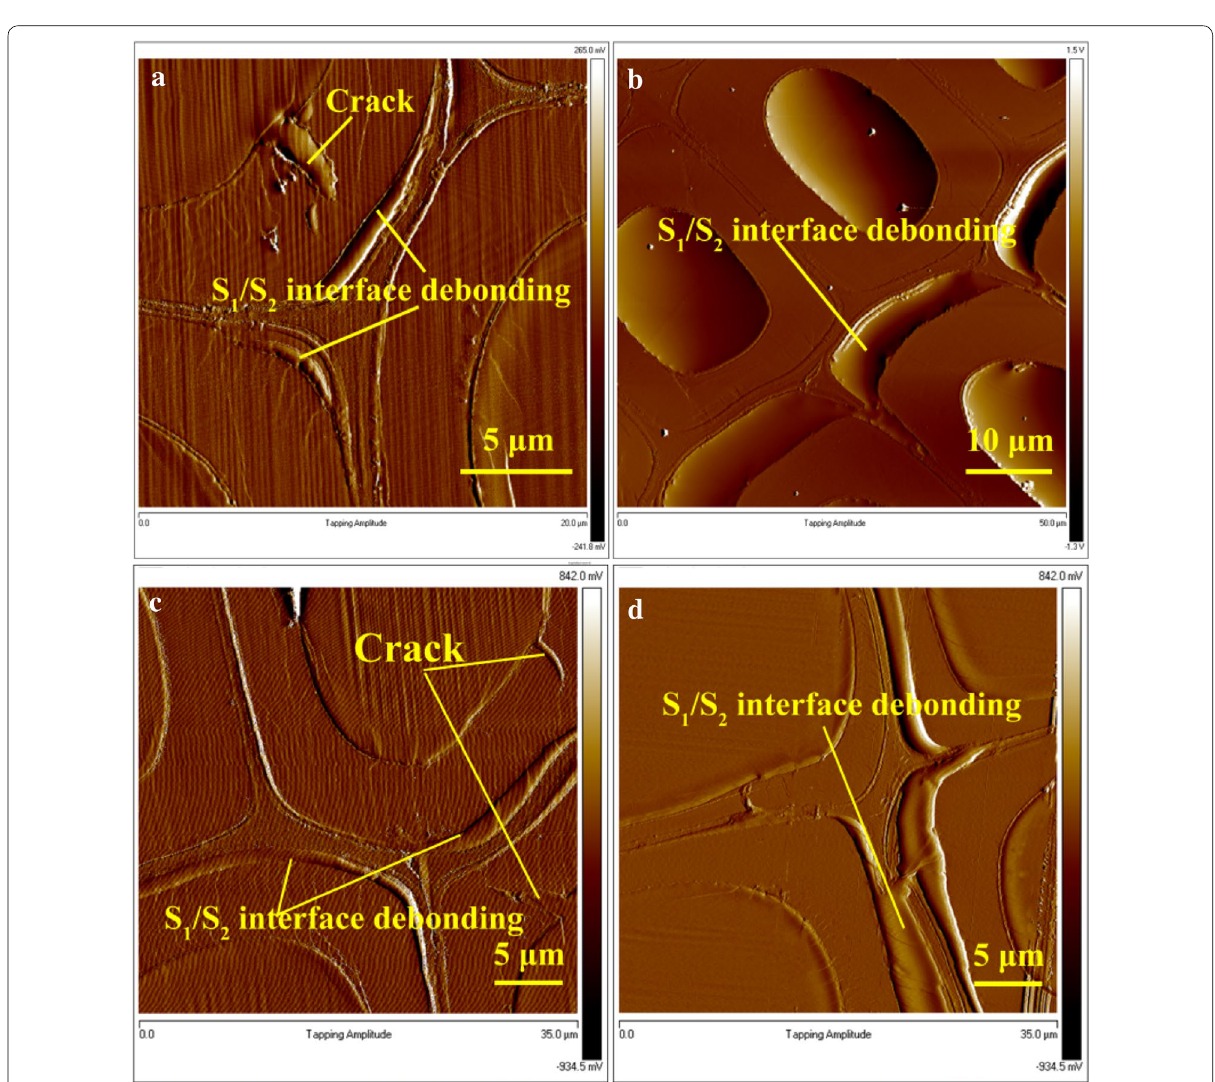
Fig. 8 Fractures of the tracheids under bend loading. a The LW fracture of the tensile parts outermost under tangential loading bend; b the LW fracture of the neutral layer under tangential loading bend; c the LW fracture of the tensile parts outermost under radial loading bend; d the EW fracture of the neutral layer under radial loading